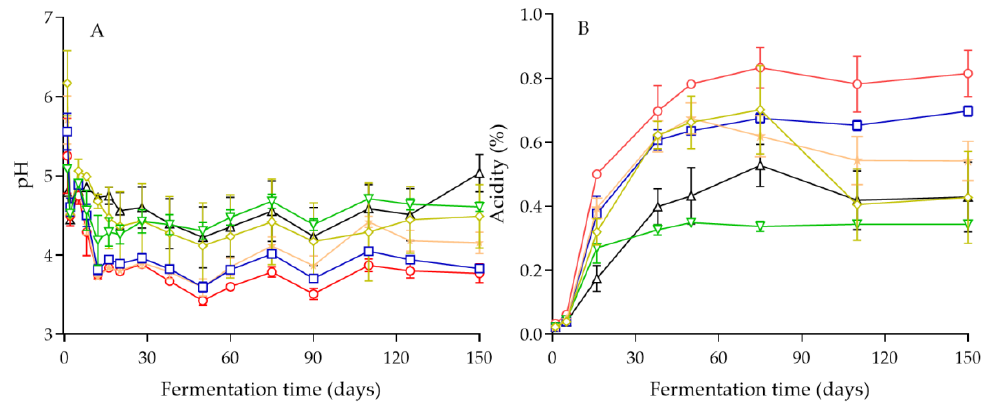
Figure 2. Changes in pH (A) and titratable acidity (%) (B) during inoculated fermentation of cv. Kalamata natural black olives with selected yeast starters: C. boidinii Y27 ( ), C. boidinii Y28 ( ), C. boidinii Y30 ( (cid:53) ), C. boidinii Y31 ( (cid:3) ), S. cerevisiae Y34 ( ∆ ), and spontaneous fermentation ( ♦ ). Data points are mean values of duplicate fermentations ± standard deviation.